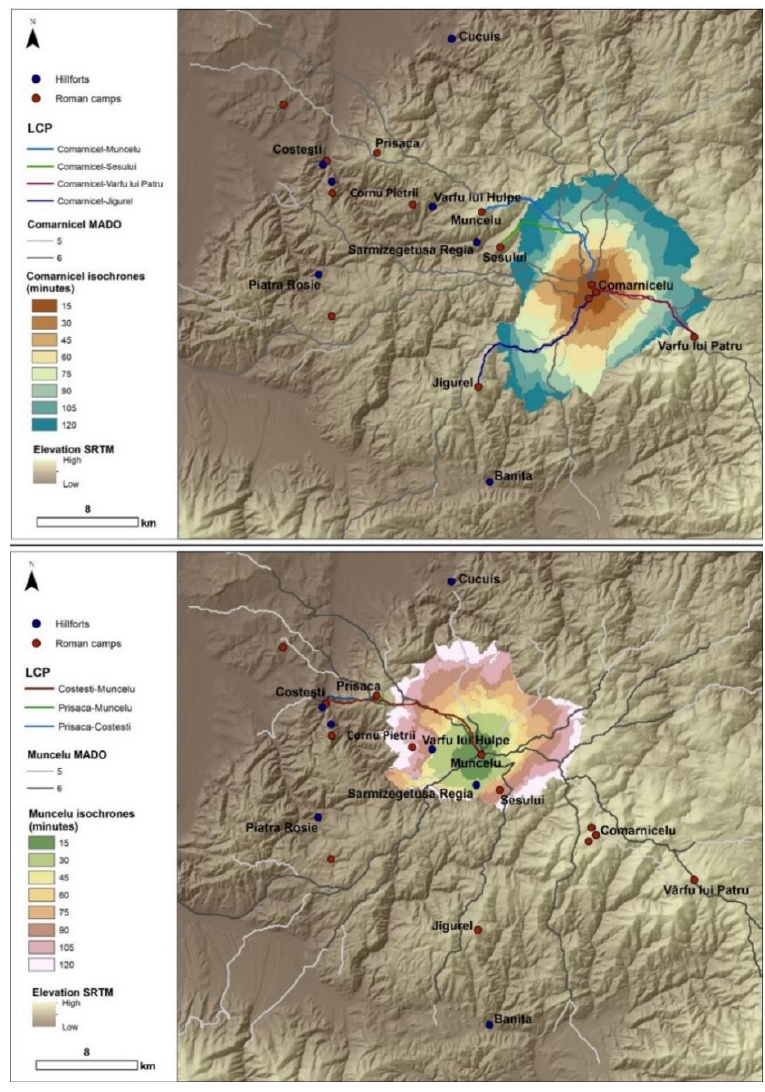
Figure 5. Results of mobility analysis (LCP and MADO) from the Roman army bases at Comărnicelu ( above ) and Muncelu ( below ), indicating area of immediate reach (up to 2 h).